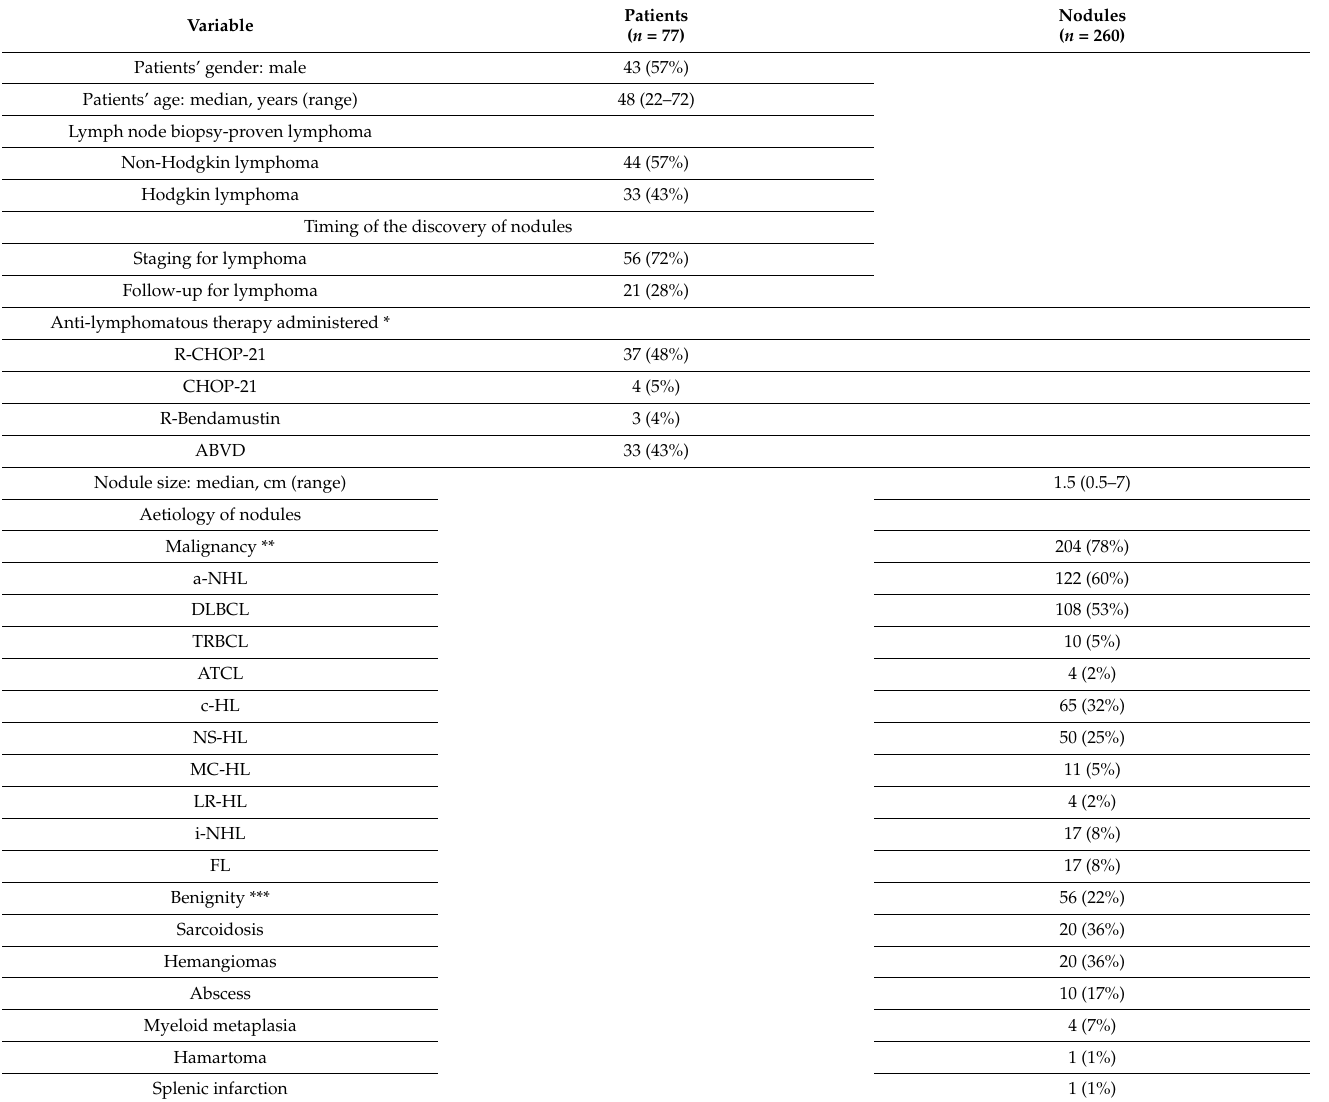
Table 1. Patient and splenic nodules